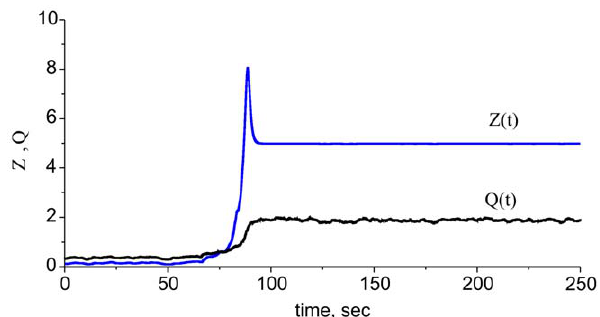
Figure 11. Dynamics of the ECM receptor regulation cascade in the spiking model (1)–(6), (9), and (10). Due to the integration of the Poisson input train, the Q variable begins fluctuating near the Q ‘ value (see Eq. (7) in Methods). This figure illustrates a spontaneous transition from the lower to higher level state. Parameter values: z 0 =p 0 =0, z 1 =p 1 =1, h z =1,k z =0.15, h p =1.5,k p =0.05, k q =0.01, c p =0.1, I o = 4.5 m A/cm 2 , b 0 = 6.5, c Z = 0.0, c ZR = 0.065, a q = 0.0001 msec 2 1 ,